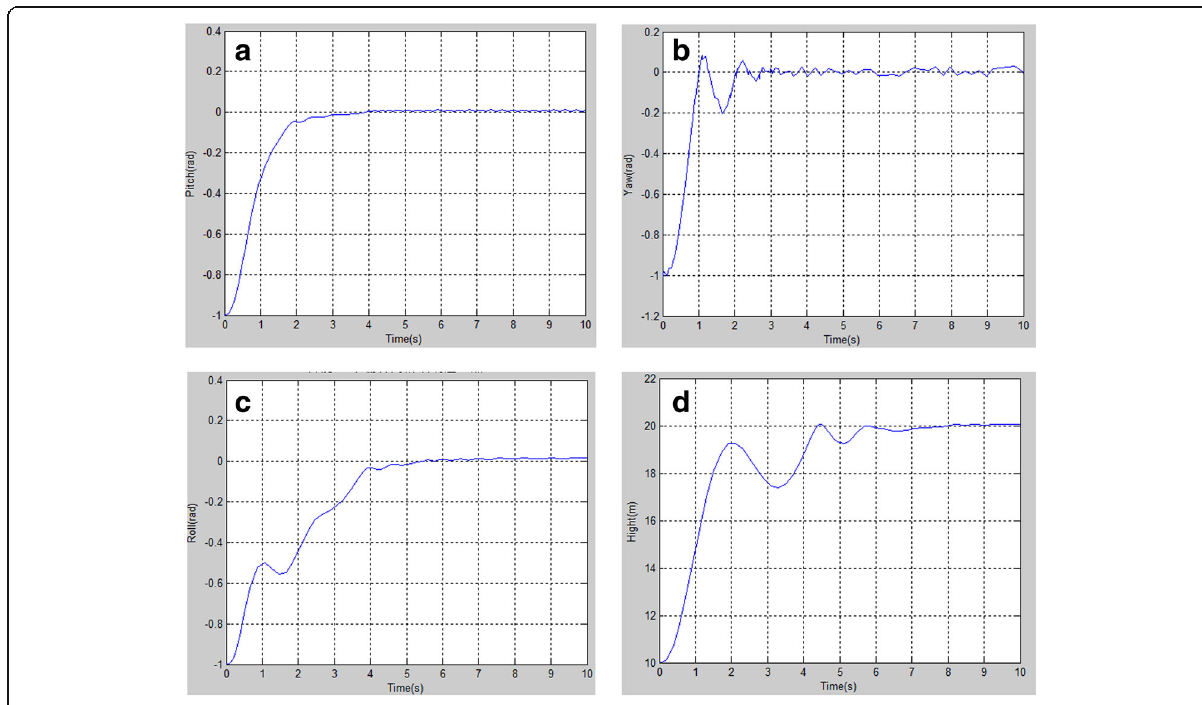
Fig. 6 The simulation results. a Pitch angle simulation; b Yaw angle simulation; c Roll angle simulation; d Height simulation